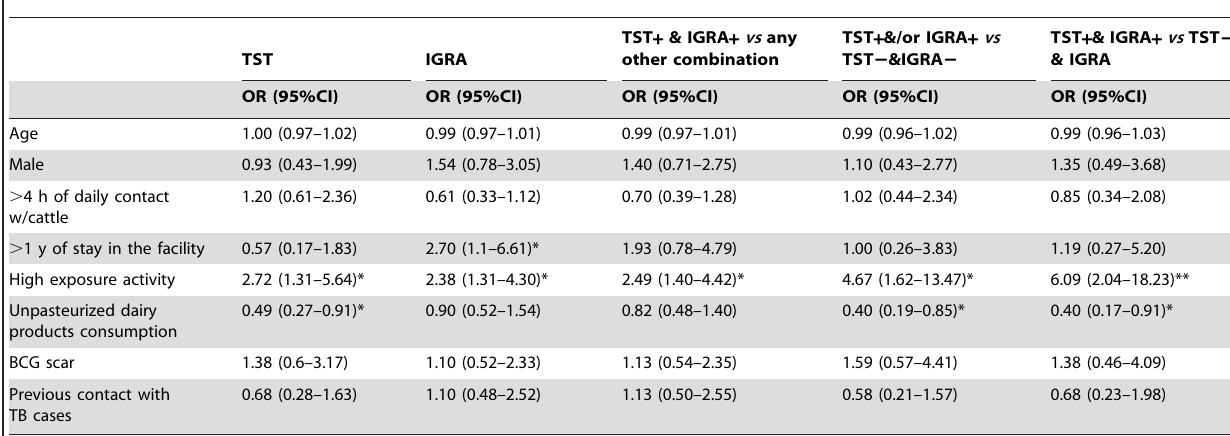
Table 5. Characteristics associated to tuberculosis skin test and interferon- c release assay by multivariate